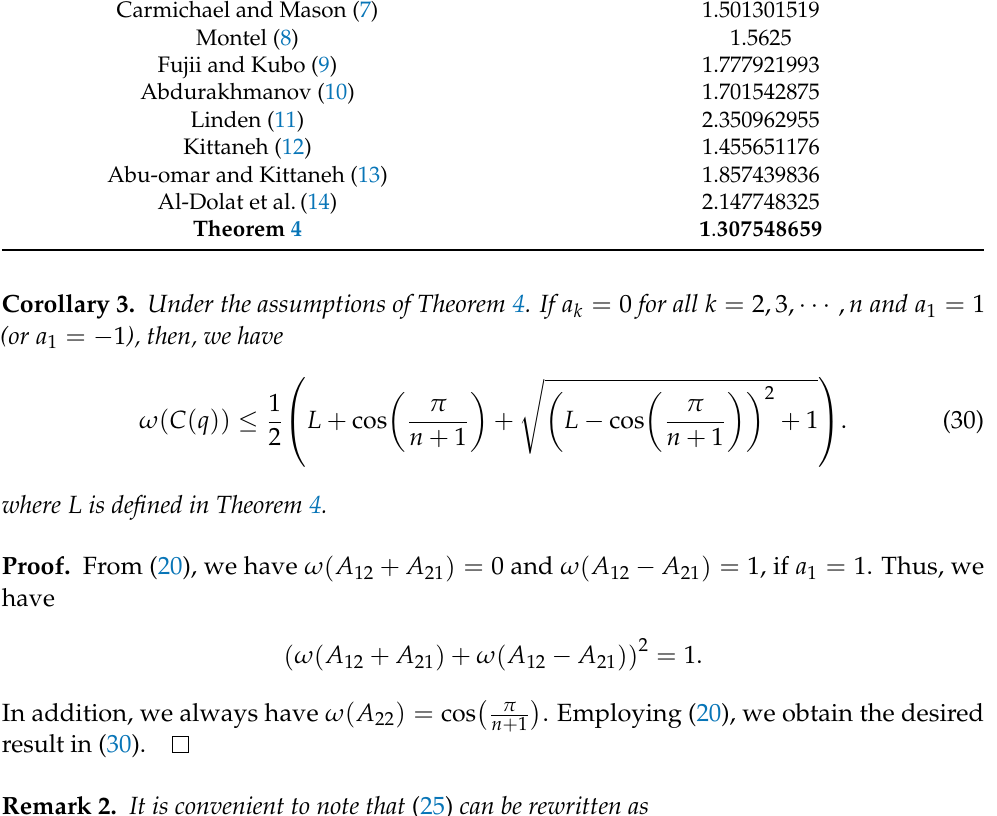
Table 3. Comparisons of upper bounds based on the considered polynomial q 3 ( z ) . Mathematician Upper Bound Cauchy